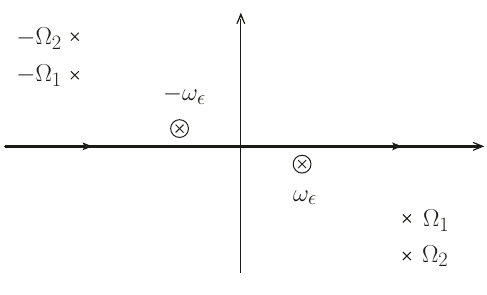
Figure 29 . Poles of the half propagators